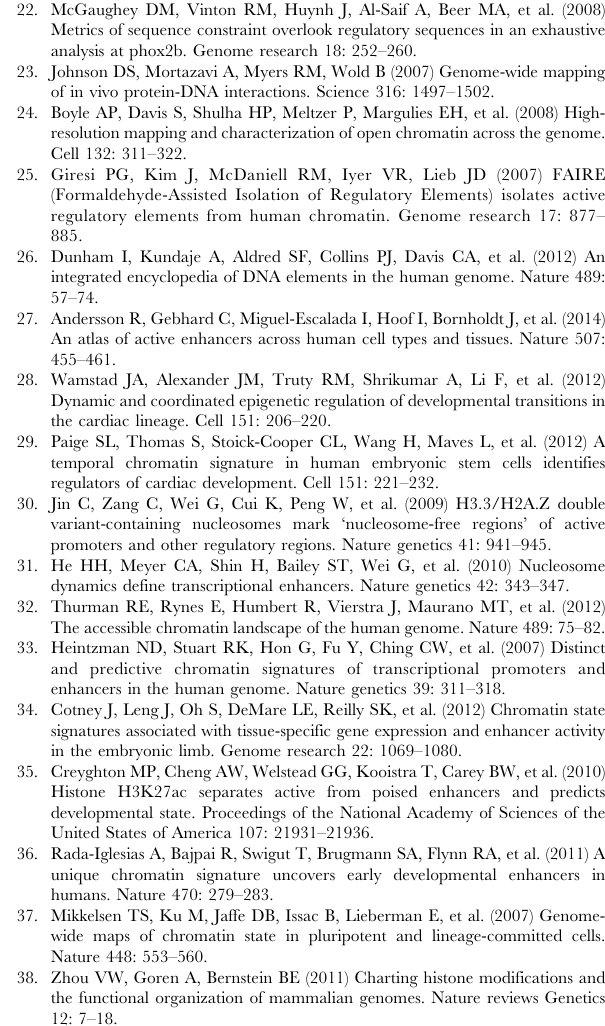
Table S4 The top 25 transcription factors for which binding sites were most prevalent in brain, heart, and limb enhancers. Table S5 676 GWAS SNPs are found in predicted enhancers. This Excel spreadsheet lists all GWAS SNPs from the NHGRI database that fall within one of our predicted enhancers. Table S6 Candidate enhancer regions tested in zebra- fish. We tested 10 candidate enhancer regions in a transgenic zebrafish assay. This table lists the genomic coordinates (hg19) and expression patterns observed for each construct at 24 and 48 hpf. A representative fish is shown for each positive enhancer in (Figures 7 and S9). Candidate enhancers on chromosome 6 are near FOXC1, and those on chromosome 16 are near FOXC2. N is the number of zebrafish alive at the specified time point, and * indicates expression patterns that are ‘‘suggestive,’’ but below the 15% threshold we used for confirmed enhancers. (DOC) Data File S1 This ZIP archive contains BED files (hg19 coordinates) with EnhancerFinder’s genome-wide